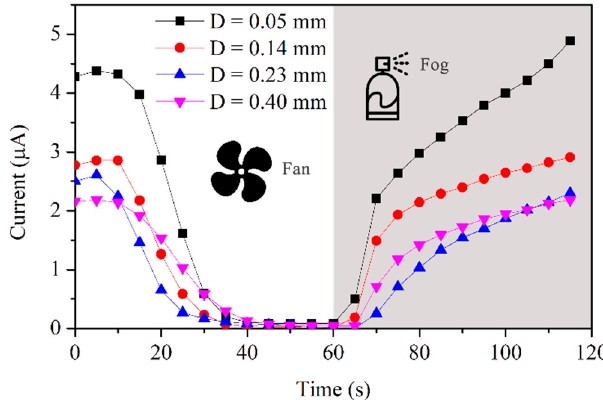
Figure 3. Sensor sensitivity described by the current versus the thickness of epoxy.